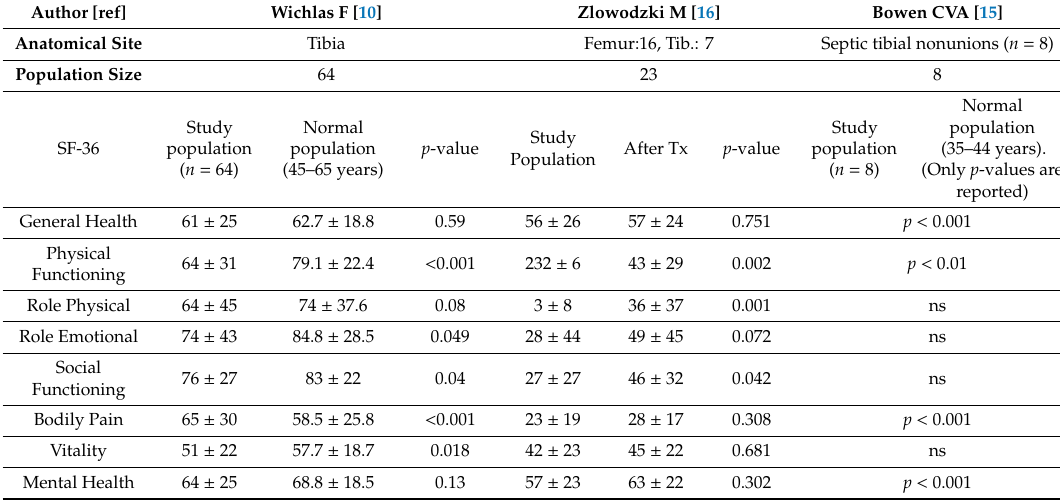
Table 5. Results of the SF-36 in the non-pooled